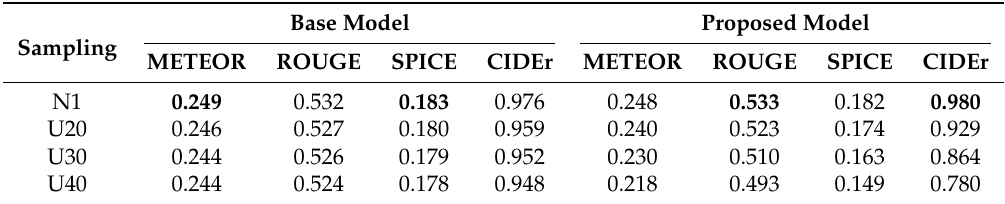
Table 1. Experimental results of captioning accuracy with the base model and the proposed model. Both evaluation results are comparable with N1 sampling.